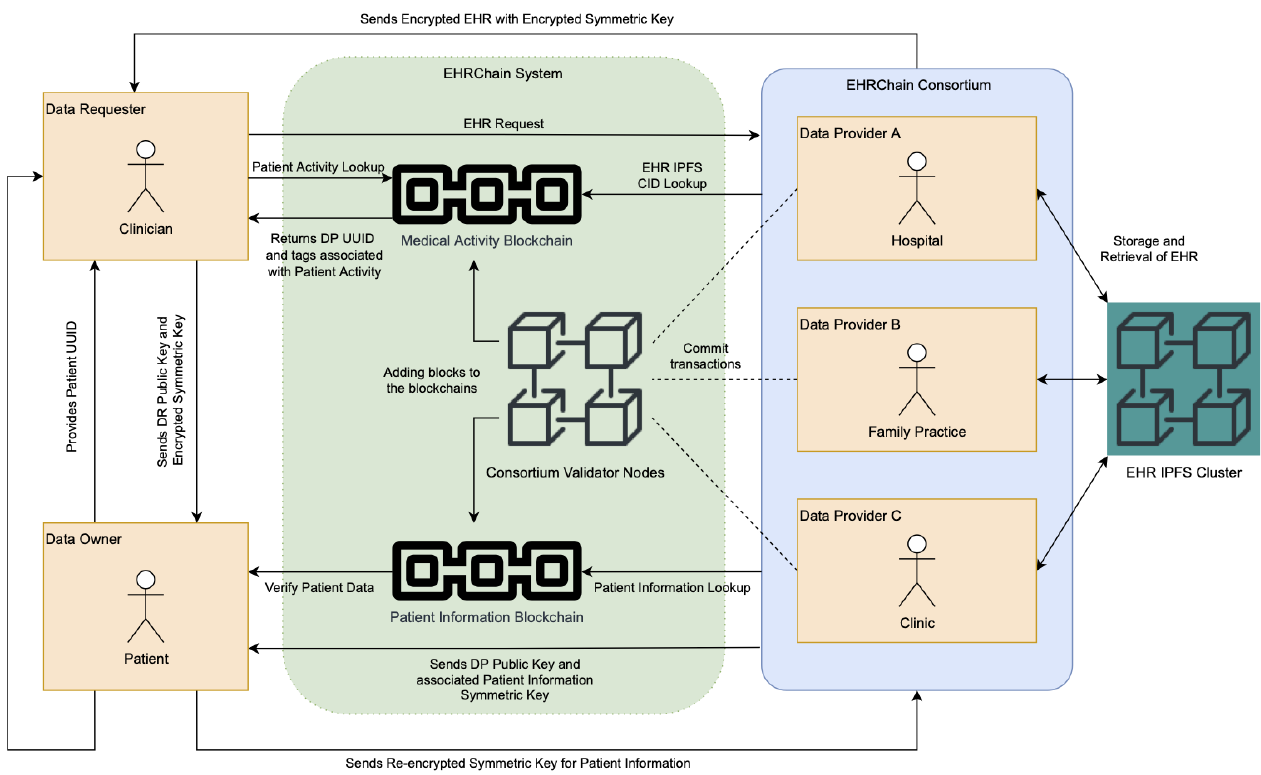
Figure 8. EHRChain system architecture.